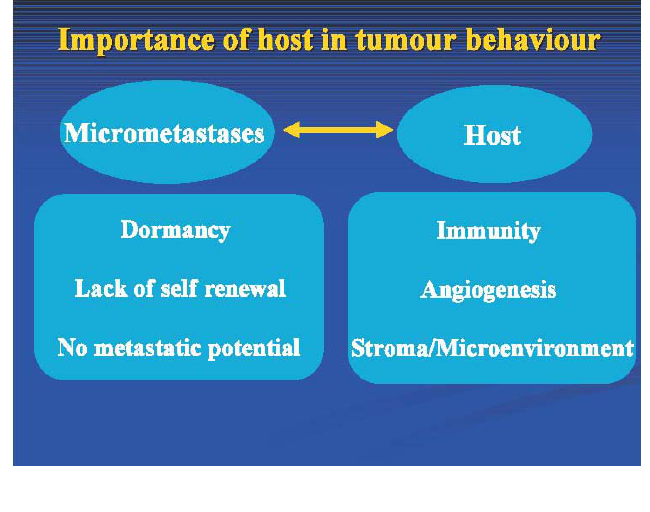
Figure 2. Features important for the consideration of the long-term outcome of patients with detectable micrometastases; note that a substantial number of patients with detectable microscopic disease remain disease-free in the long-term. Features of the tumor, the host, and the interaction between them may be important. Future prognostic tools may incorporate features of